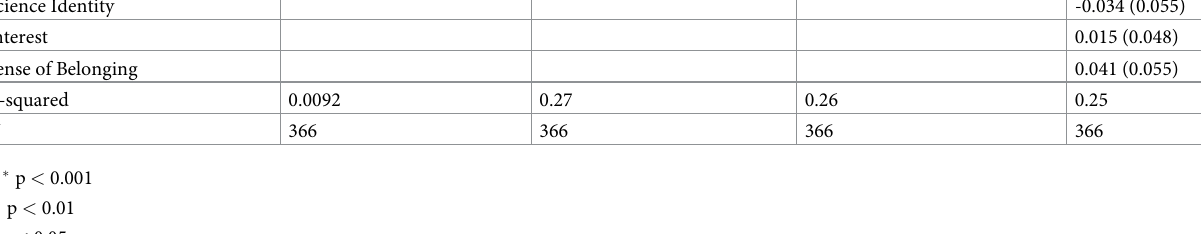
Table 6. Regression model of homework 1 scores on FMCE pre-scores and gender.